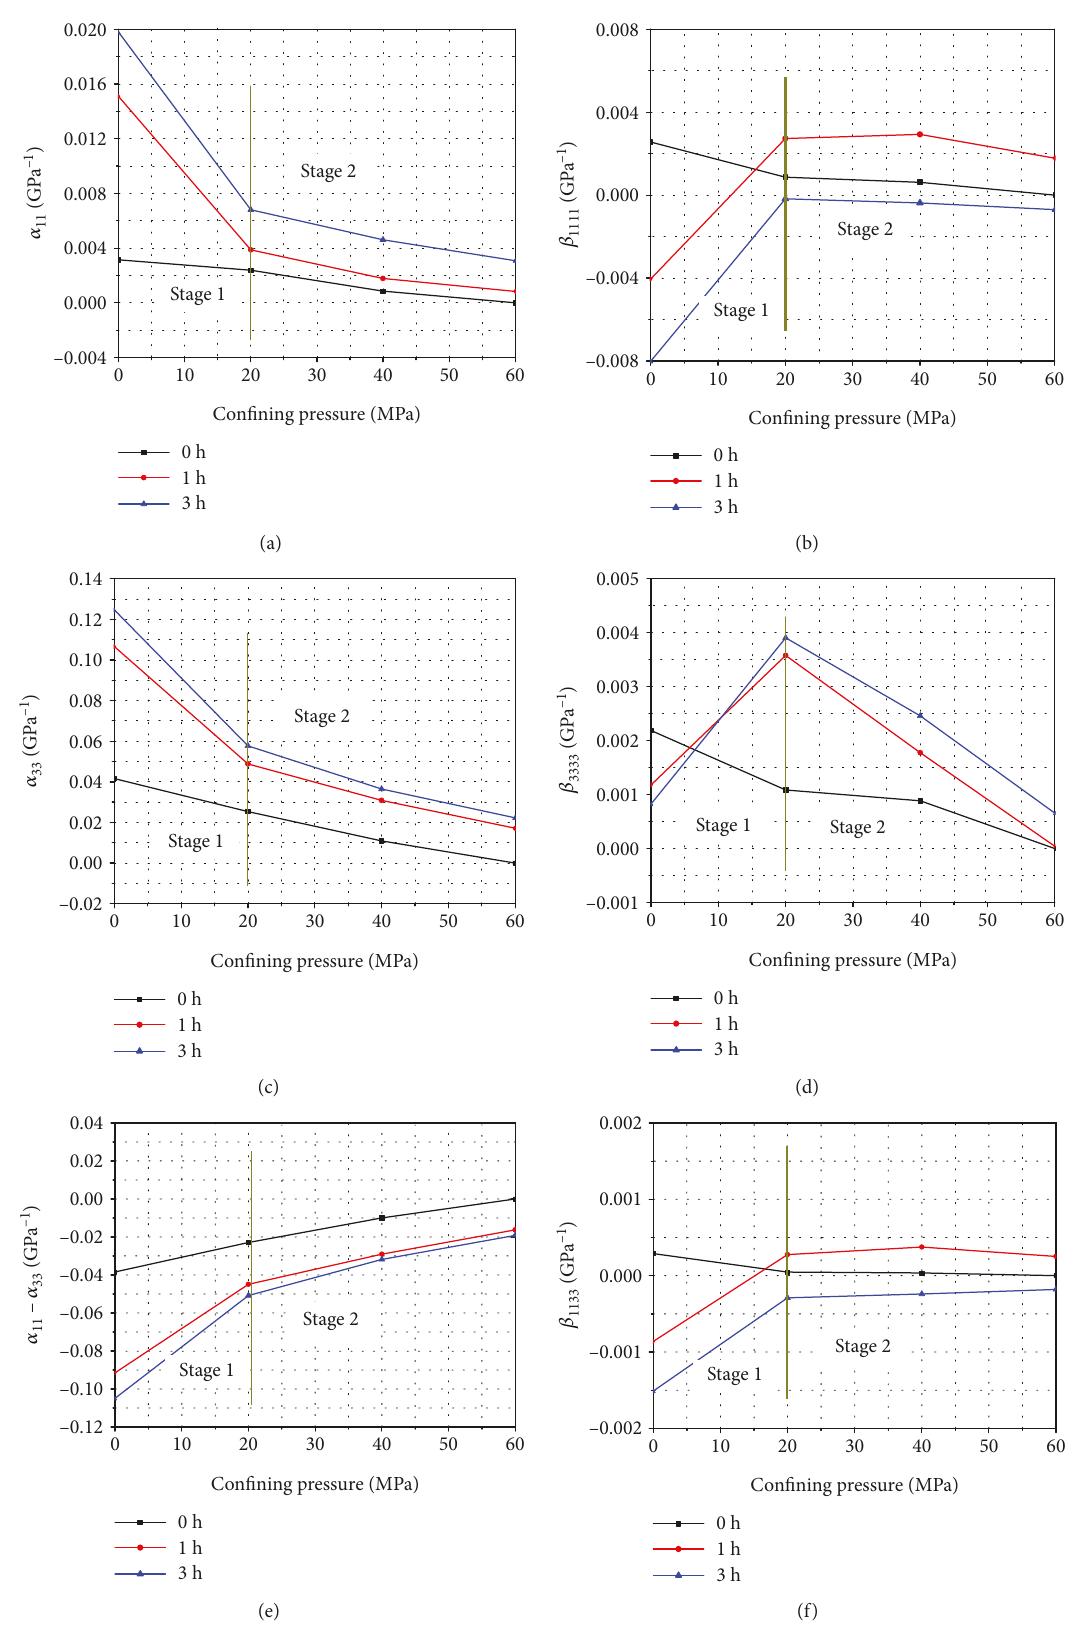
Figure 9: The relationship of damage parameters of shale and con fi ning